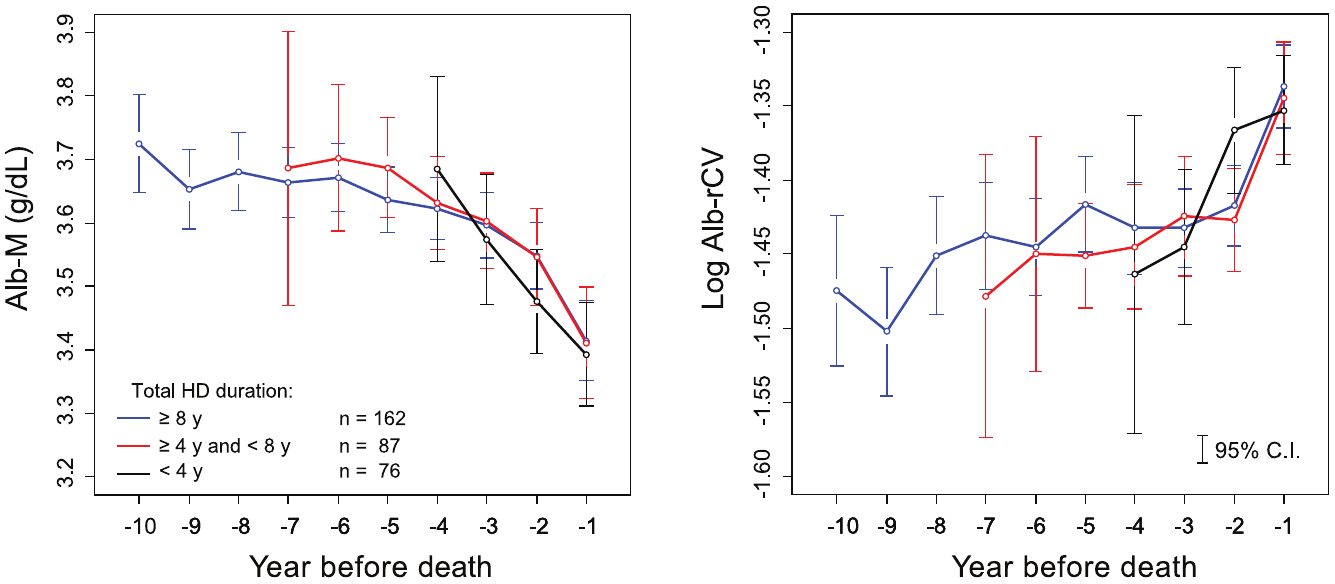
Fig 4. Duration of HD treatment and albumin dynamics prior to death. The before death subcohort was categorized into 3 groupsaccordingto the total durationof HD treatment, and the mean Alb-M or log Alb-rCV values of the groups were plotted for the year before death. https://doi.org/10.1371/journal.pone.0185216.g004 PLOS ONE | https://doi.org/10.1371/journal.pone.0185216 September 27,